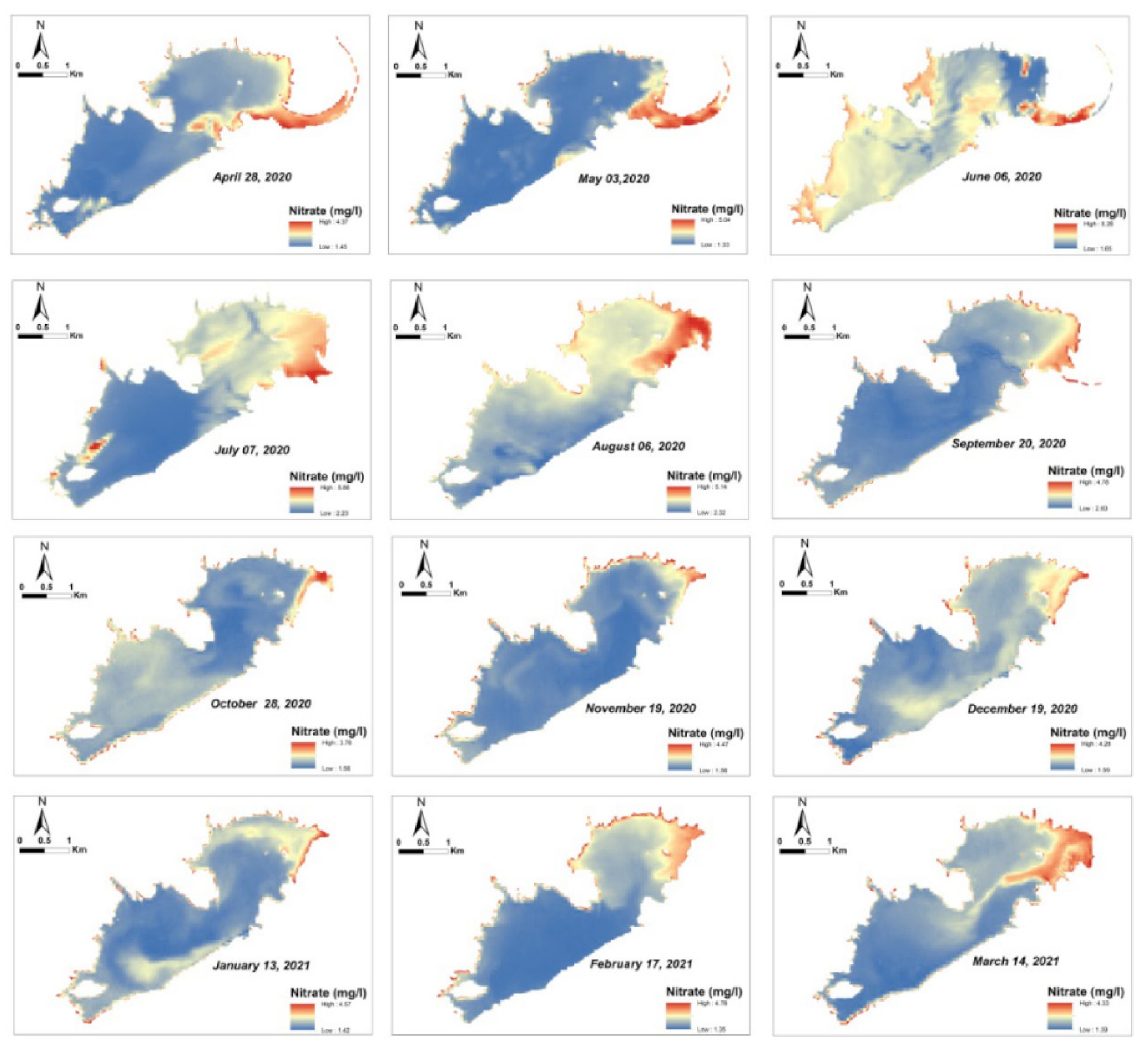
Figure 7. Obtained maps of nitrate using best model.